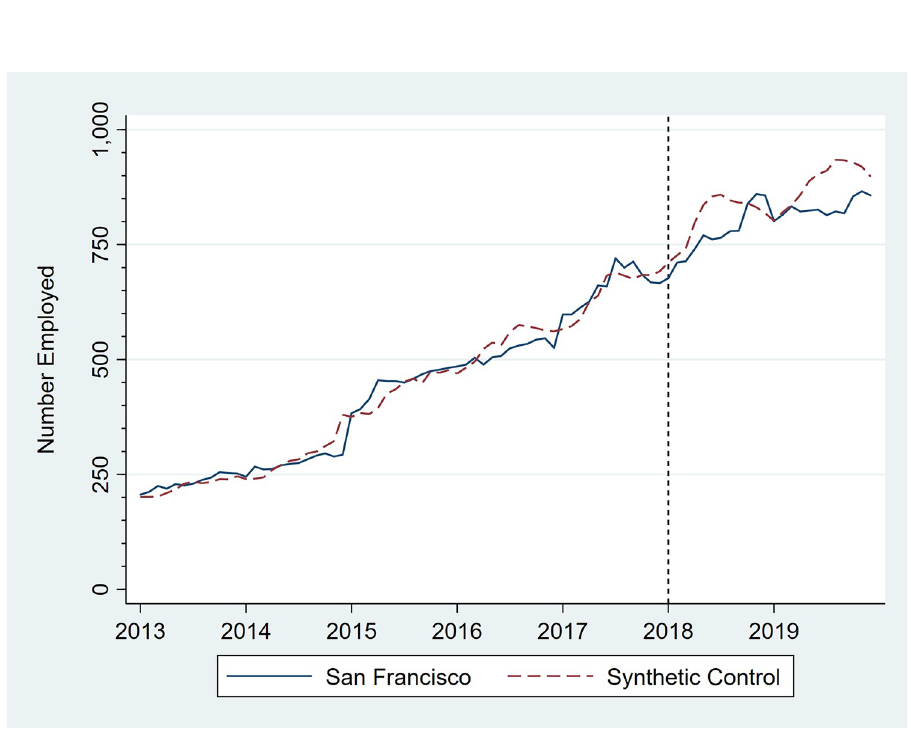
Fig 6. Number of persons employed in beverage manufacturing, San Francisco, CA, and its synthetic control, monthly, January 2013 through December 2019.